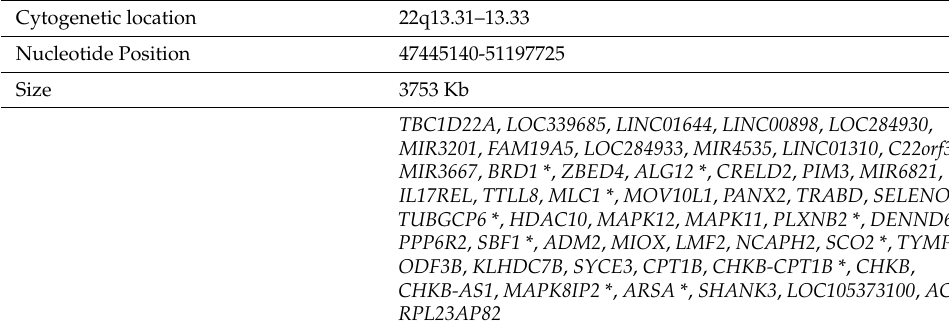
Figure 2. CMA revealed a 3.7 Mb microdeletion at 22q13.3 (red arrow) in the younger sister in this family. Table 1. List of genes deleted in the region of this microdeletion. Table 1. List of genes deleted in the region of this microdeletion.